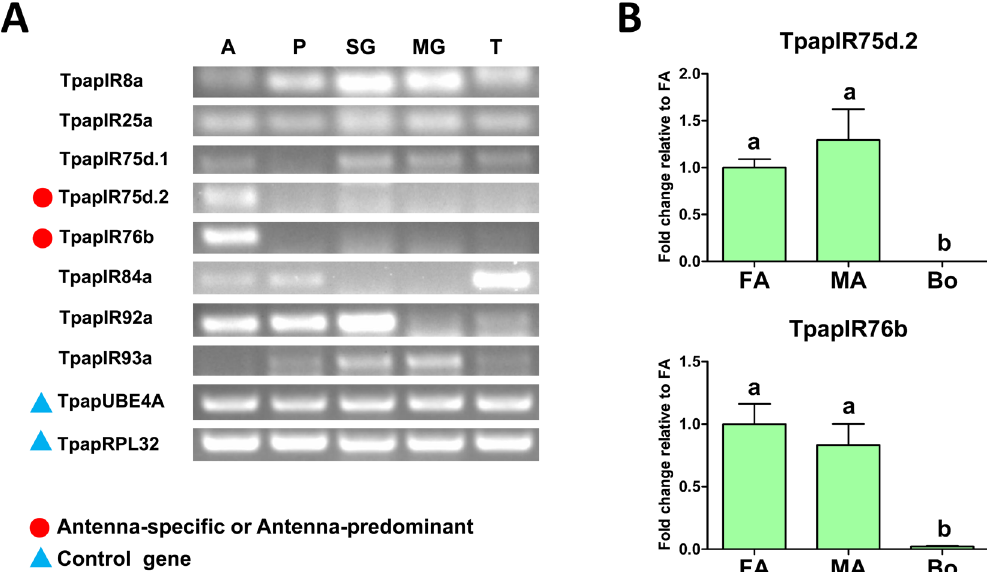
Figure 5. ( A ) Transcriptional profiles of putative T . papillosa iGluRs/IRs in different body parts as determined by semi-quantitative RT-PCR. Red dots represent iGluRs/IRs that are upregulated in the antenna. Two reference genes labeled with blue triangle, ubiquitin conjugation factor E4 A (TpapUBE4A) and 60 S ribosomal protein L32 (TpapRPL32), were used as internal references to test the integrity of each cDNA template. Abbreviations: A: antenna; P, proboscis; SG, stink gland; MG, midgut; T, tarsus. ( B ) Relative expression levels of antenna- predominant iGluRs/IRs in the female and male antennae, and other body parts. Abbreviations: FA, female antennae; MA, female antennae; Bo, other body parts (the pooled tissue mixture of proboscis, stink gland, midgut, foreleg tarsus, and wing). The expression levels were estimated using the 2 −ΔΔ CT method. Relative expression level is indicated as mean ± SE (n = 4). Standard error is represented by the error bar, and different letters indicate statistically significant difference between tissues (p < 0.05, ANOVA,